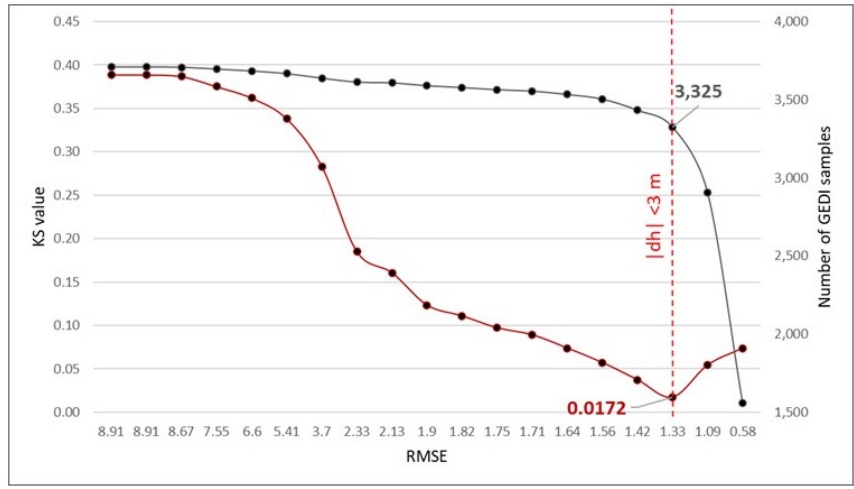
Figure 4. Optimal threshold of calculated KS (red color), RMSE (red dashed line) values, and the number of GEDI samples (grey color).